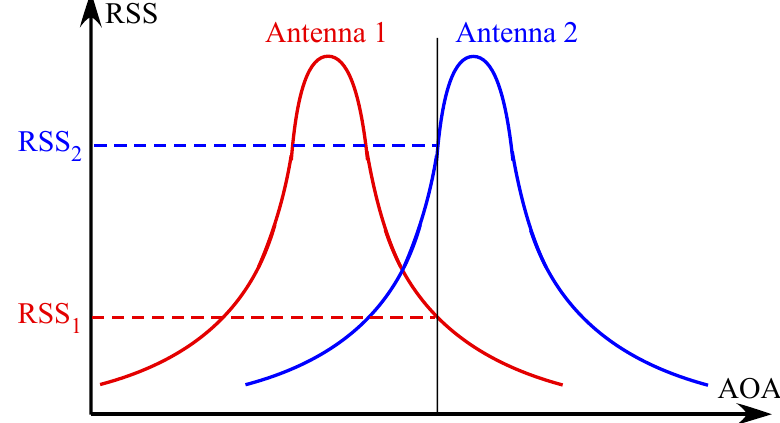
Figure 5. Illustration of angle of arrival (AOA) estimation process based on the received signal strength (RSS) ratio, RSS 1 /RSS 2 , between two directional